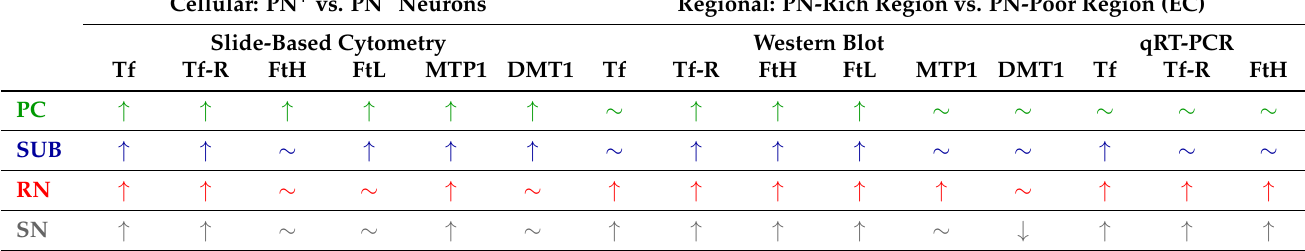
Table 1. Summary of the results that demonstrate higher iron protein levels in PN + neurons (left) and summary of the regional iron protein (middle) and mRNA analyses (right). Note: The regional analyses also include non-neuronal sources of protein/mRNA, which reduce the PN + effect, especially for regions with low PN + contents (PC, SUB). ↑ increase, ↓ decrease, ∼ no difference. Cellular: PN + vs. PN – Neurons Regional: PN-Rich Region vs. PN-Poor Region (EC) Slide-Based Cytometry Western Blot qRT-PCR